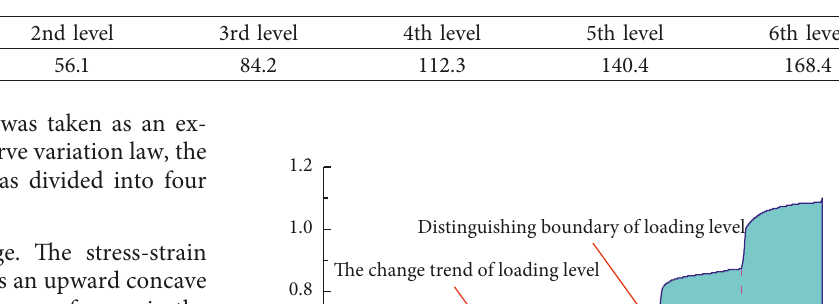
Table 3: Load value of 1st to 6th level.